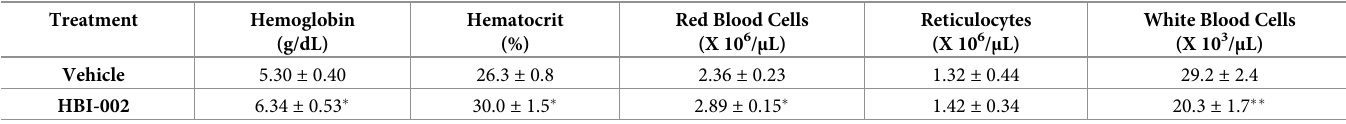
Table 1. HBI-002 increases hemoglobin, hematocrit and red blood cells and decreases white blood cells in Townes-SS mice. Treatment